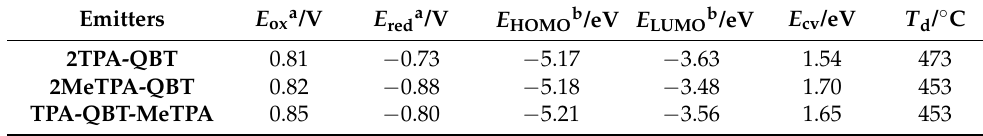
Table 1. Thermal stability and electrochemical data for the three